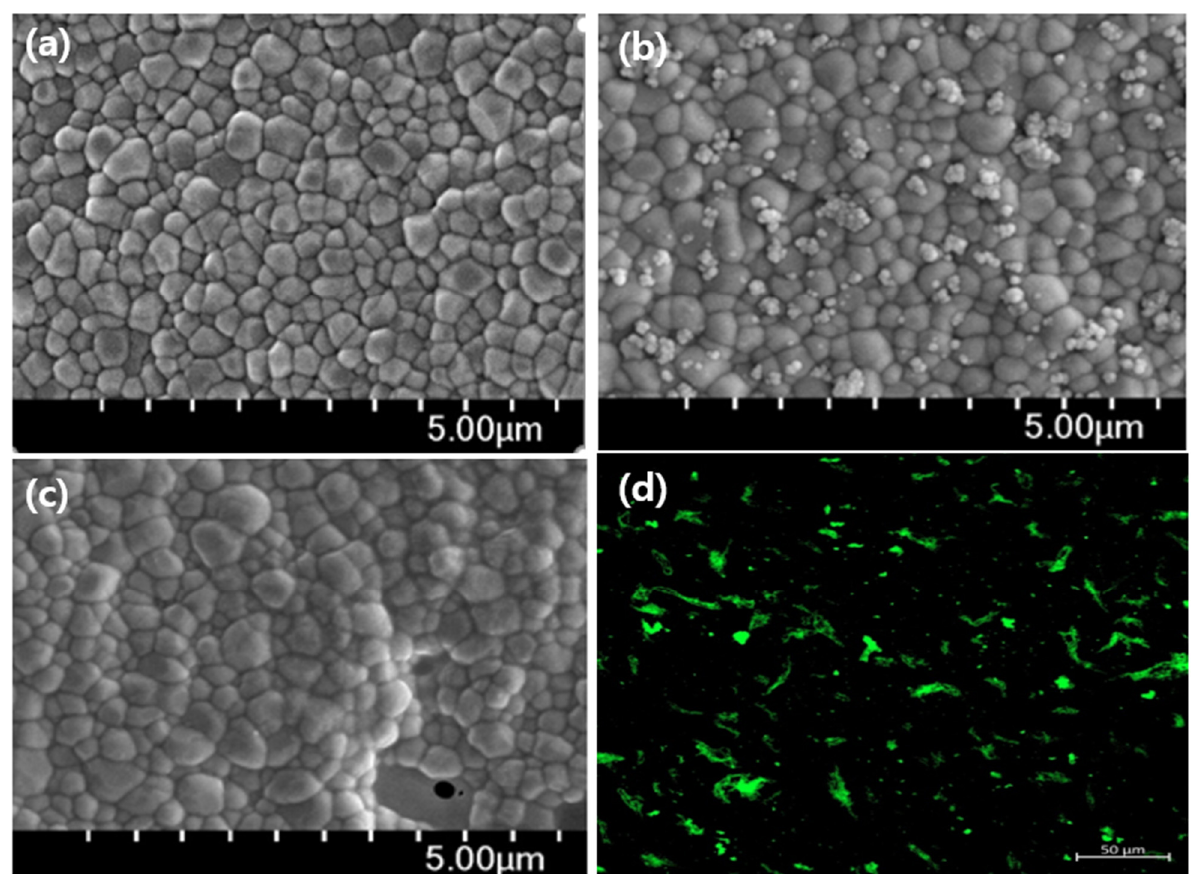
Figure 7. Images of surface-modified step-by-step zirconia implants. SEM images of ZrO 2 ( a ), ZrO 2 - HA ( b ), ZrO 2 -HA-Col ( c ), and confocal fluorescence image of ZrO 2 -HA-FITC-Col ( d ). It can be seen that nHA particles with a diameter of 20 to 70 nm are bound in ZrO 2 -HA. Once the collagen binds to the nHA, the image of the nHA particles disappears. The presence of collagen can be confirmed by confirming the green image by reacting the FITC-labeled collagen and then measuring it with a confocal fluorescence microscope.